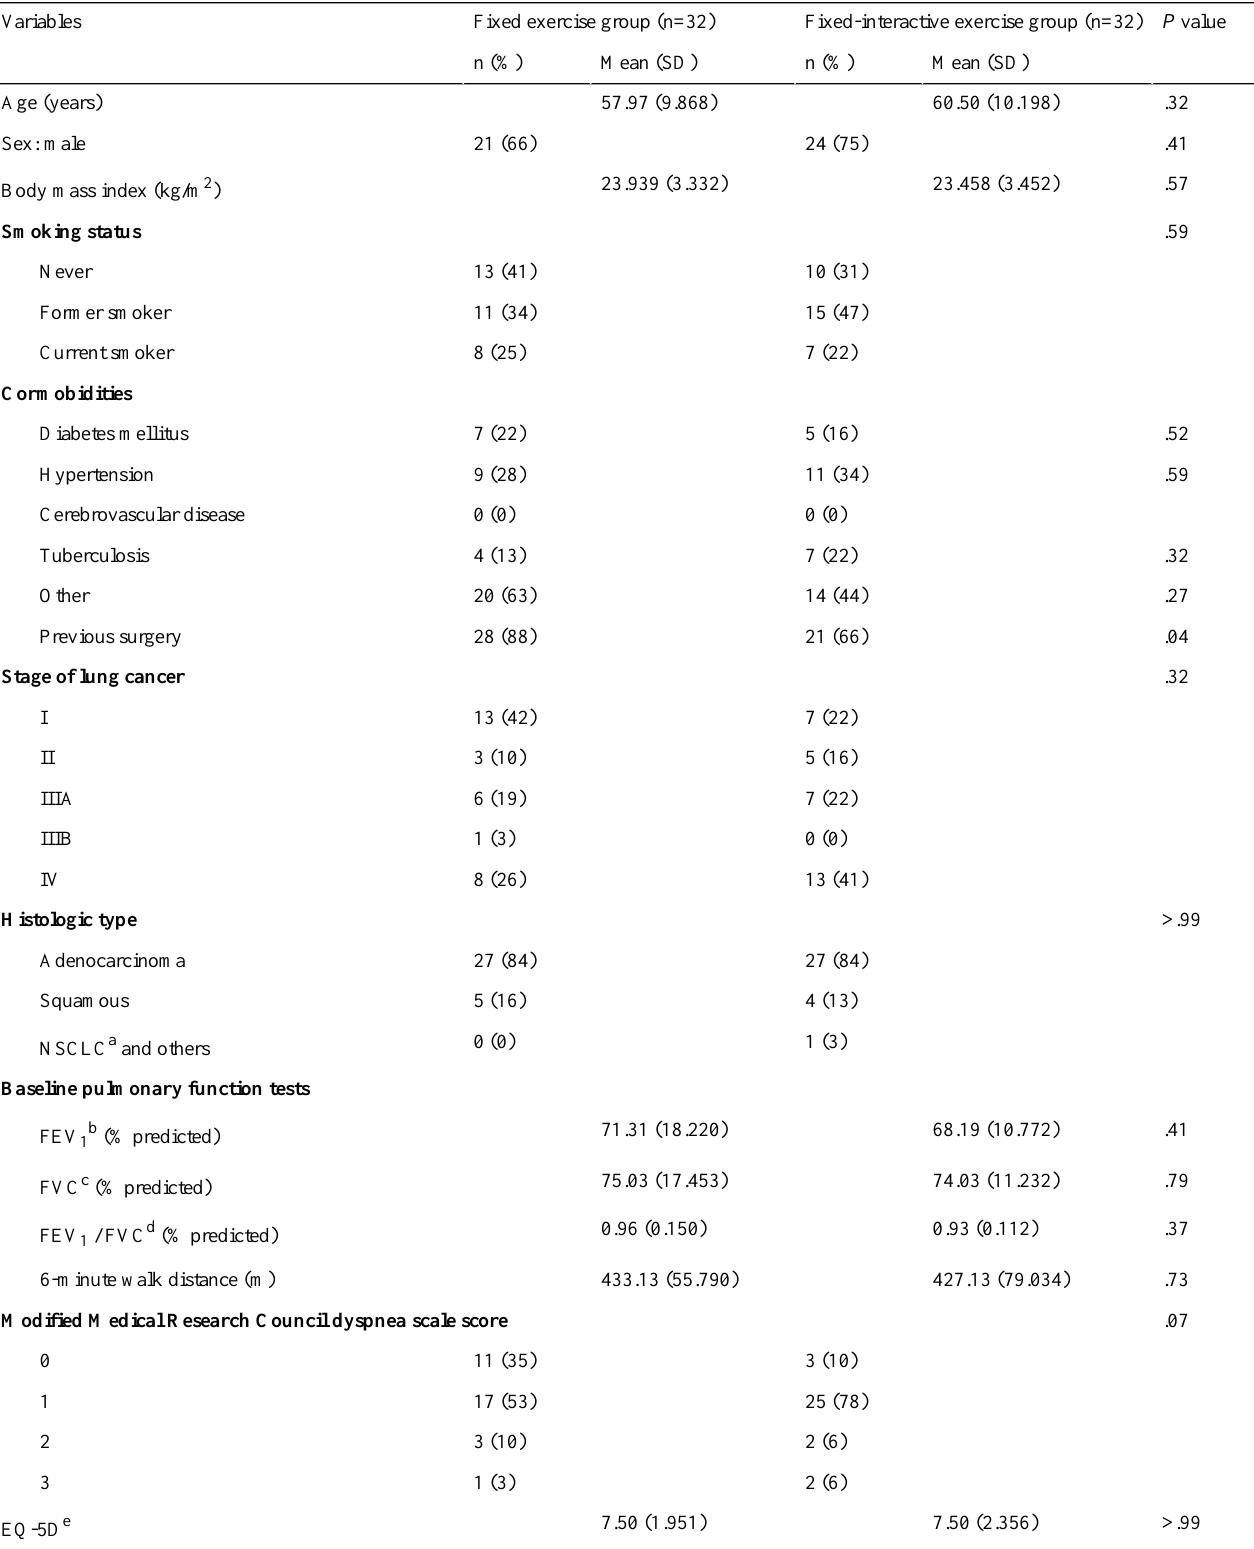
Table 1. Baseline participant characteristics